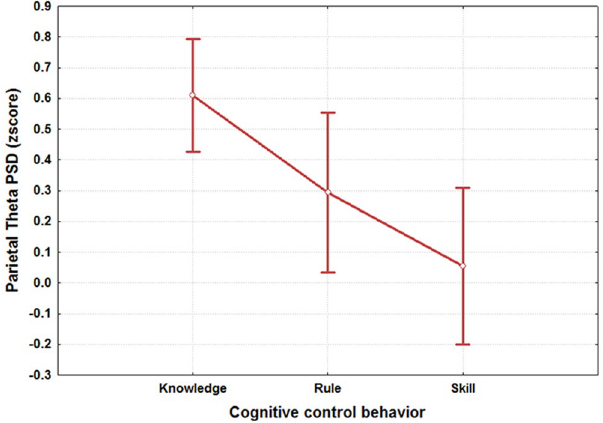
Figure 5. The figure reports the results of the ANOVA analysis (CI = 0.95) on the parietal theta PSD with the factor “SRK” of 3 levels (Skill, Rule and Knowledge) The results showed that such brain feature could be used as SRK discriminant brain feature, as its PSD values were significantly different (p = 0.02092) between the S, R and K